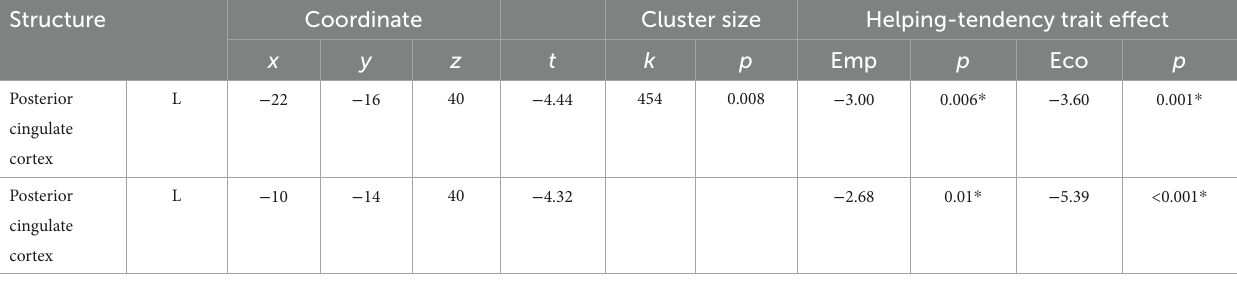
TABLE 4 Effect of helping-tendency trait during helping decision (EmpDec + EcoDec).